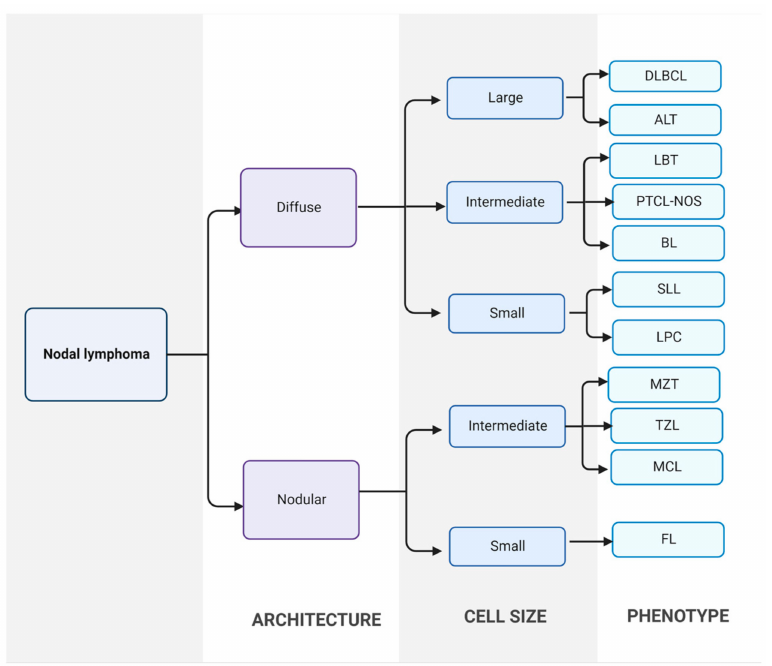
Figure 1. Classification of canine nodal lymphoma. First, lymphomas are divided into diffuse or nodular forms using excisional lymph node sections. Then, neoplastic populations are divided into large, intermediate, and small cells. Finally, final diagnosis is established. DLBCL: diffuse large B-cell lymphoma; ALT: anaplastic large T-cell lymphoma; LBT: T-cell lymphoblastic lymphoma; PTCL-NOS: peripheral T-cell lymphoma; BL: B-cell lymphoma; SLL: small lymphocytic lymphoma; LPC: lymphoplasmacytic lymphoma; MZL: marginal zone lymphoma; TZL: T-zone lymphoma; MCL: mantle cell lymphoma; FL: follicular lymphoma